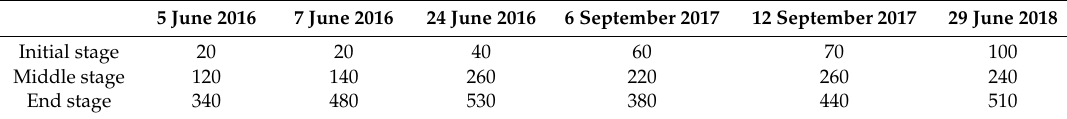
Table 1. The sampling time after drainage (unit / min).